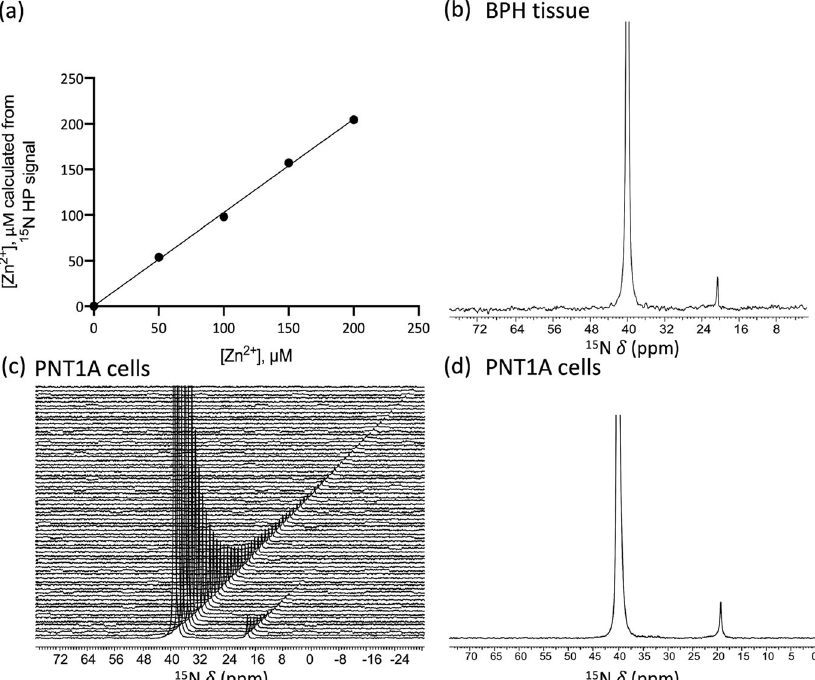
Fig. 5 Quantitative detection of [Zn 2 + ] in biological samples. a A plot of [Zn 2 + ] as determined by HP versus the analytically known [Zn 2 + ] in each sample. b – d quantitative detection of [Zn 2 + ] in a surgical specimen of human benign prostatic hyperplasia (BPH) tissue and human prostate epithelial PNT1A cells. Spectra of free ligand (40 ppm) and Zn 2 + complexes (20 ppm) were recorded every 2 s using 30° and 45° fl ip angle for BPH tissue and PNT1A cells. b the fi rst 15 N spectrum collected after dissolution and mixing on a 500 mg sample of BPH tissue after adding 4.2 mM HP-[ 15 N]TPA- d 6 . (9.4 T, 298K and pH 7.0). c Time-dependent 15 N spectra collected on a sample of PNT1A cells (~65 × 10 6 cells) after adding 2.8 mM HP TPA- d 6 and d the fi rst 15 N spectrum. (9.4 T, 298 K and pH